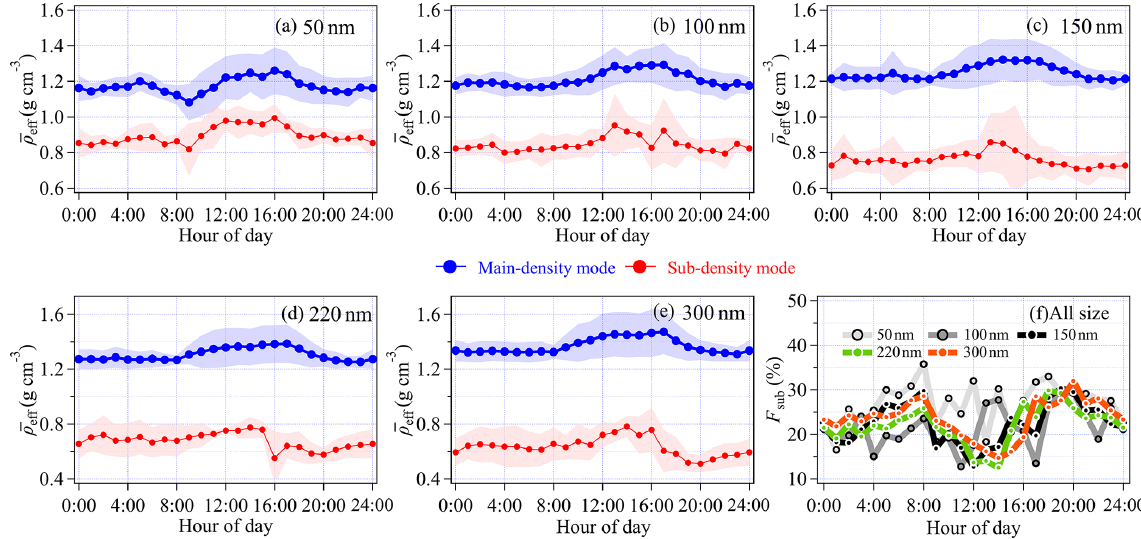
Figure 5. Diurnal cycle of the geometric mean effective density ( ρ eff ) of the main density mode and sub-density mode for (a) 50nm, (b) 100nm, (c) 150nm, (d) 220nm, and (e) 300nm particles. (f) Number fraction of the sub-density mode ( F sub ). Table 3. Comparison of the fractal dimension ( D f ) of the sub-density mode particles at noon and at night under the more polluted and less polluted conditions. D f at D f at Increase rate D f at D f